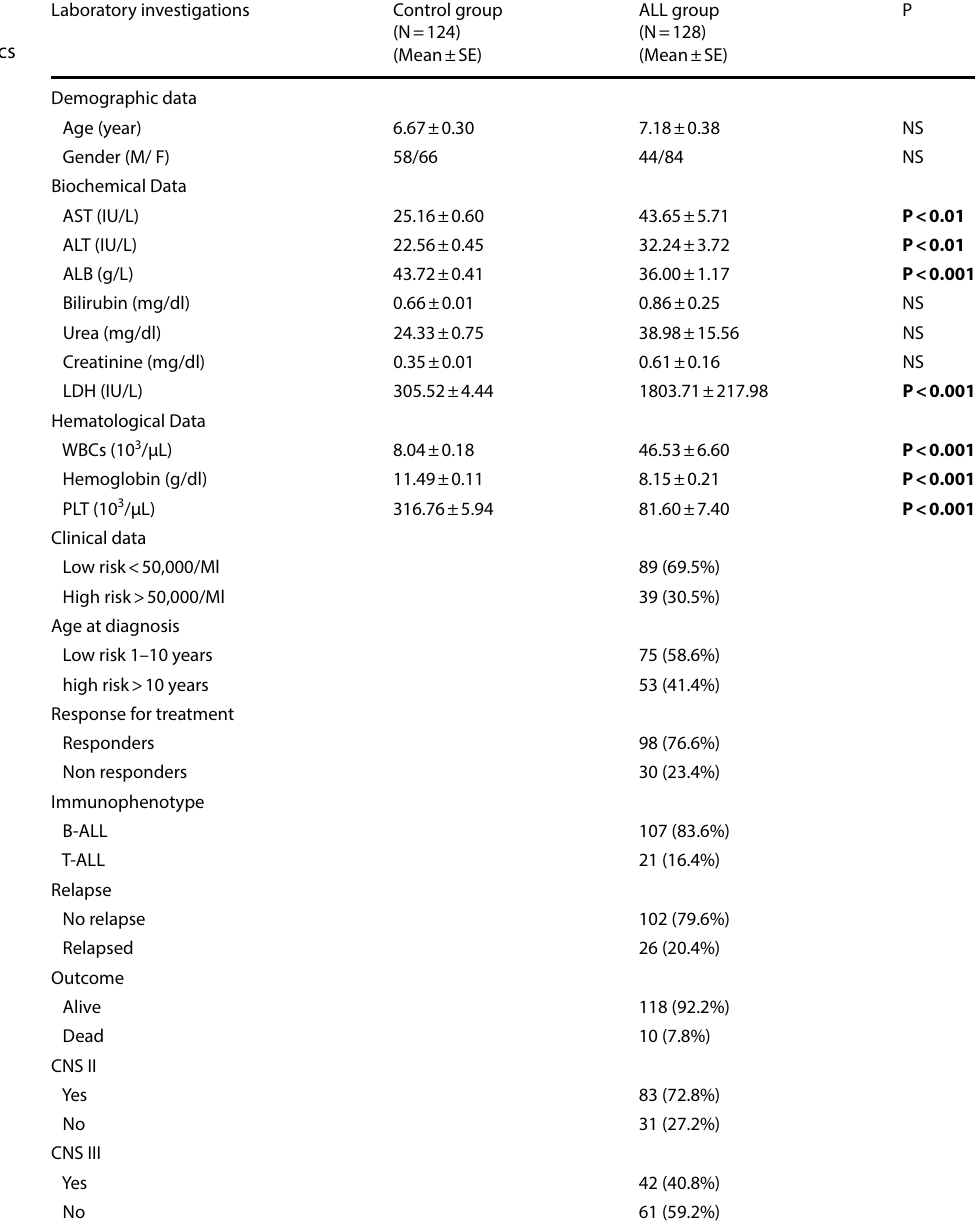
Table 1 Demographic, biochemical and hematological, characteristics of ALL patients and healthy